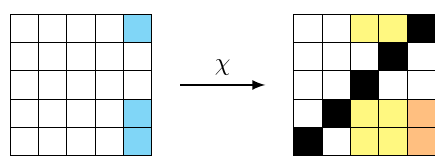
Figure 6: Fixing 3 bits on a slice before χ . The blue bits are fixed so as to linearize the expression of the yellow bits. The orange bits are equal to the blue bits with probability 0 . 75. The black bits do not matter, as those will go to the outer part after applying the remaining step